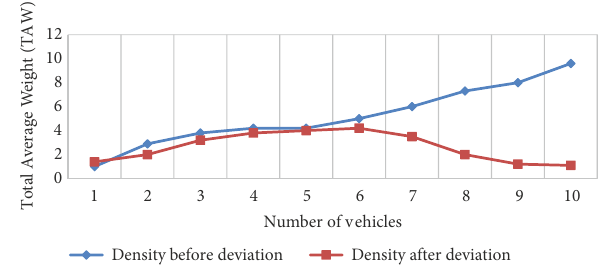
Figure 7. Comparison of approaches